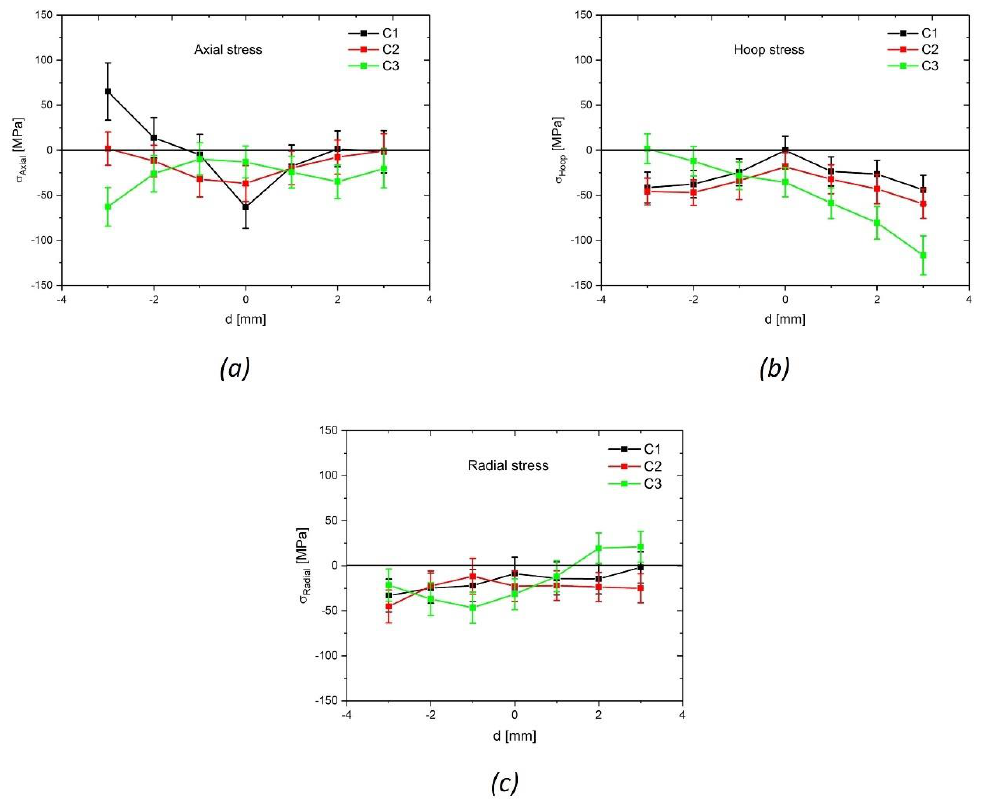
Figure 12. Residual stress distribution in the axial ( a ), hoop ( b ), and the radial ( c ) direction of the samples after the first, second, and the third C-ECAP